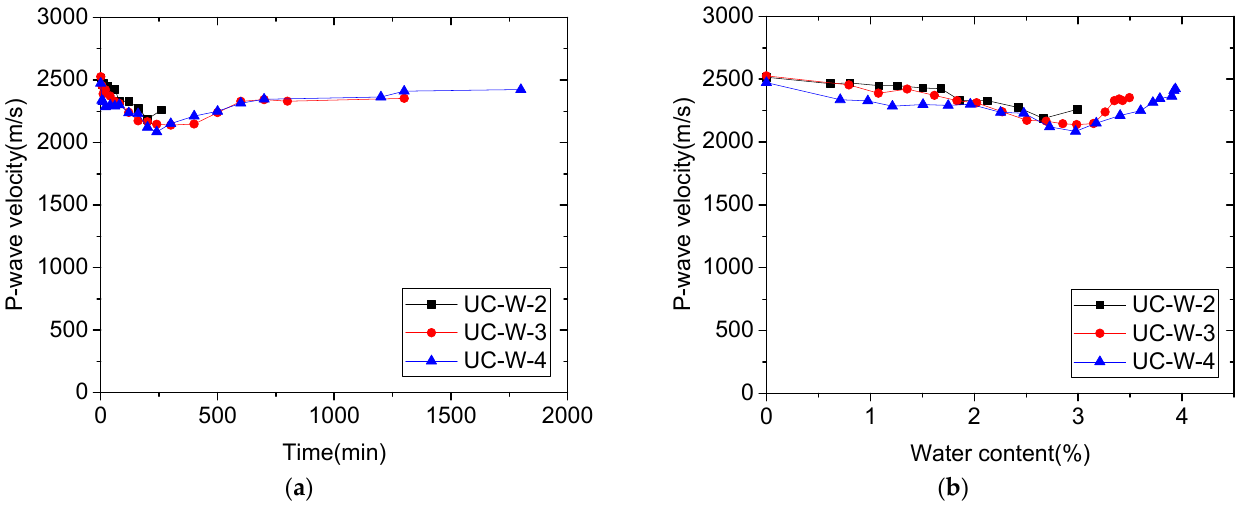
Figure 5. Variations of mean P-wave velocity with immersion time and water content: ( a ) relationship between P-wave velocity and immersion time and ( b ) relationship between P-wave velocity and water content.